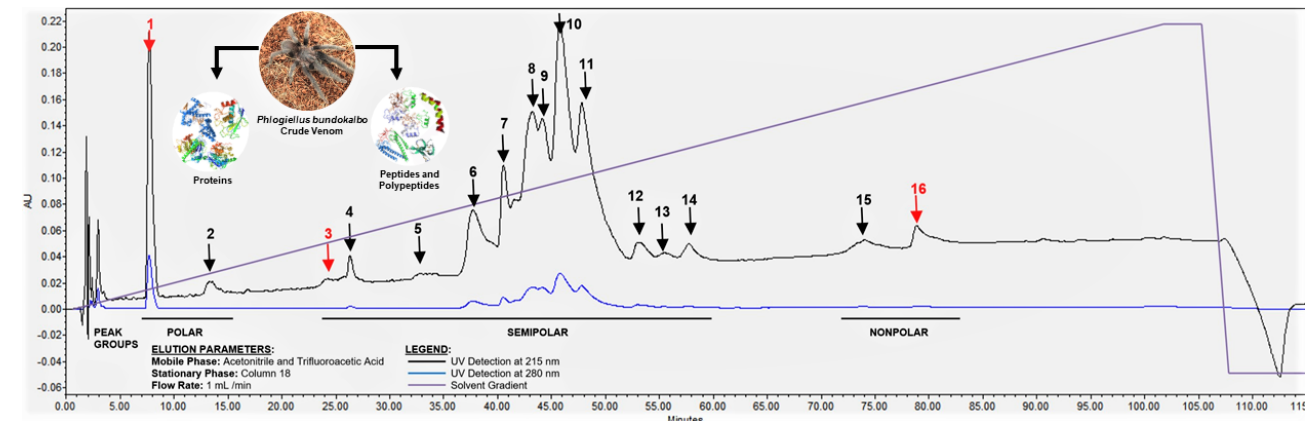
Figure 3. RP-HPLC profile of whole spider venom from Philippine tarantula. Arrows indicate the collected fractions with red color showing potent acetylcholinesterase inhibitory